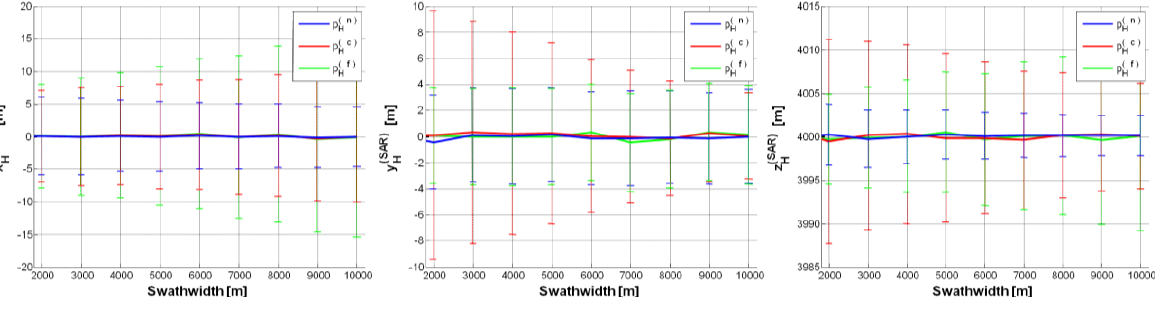
Figure 8. SAR position estimates (CS#5 in Table 2) based on a single GCP ( ( ) n